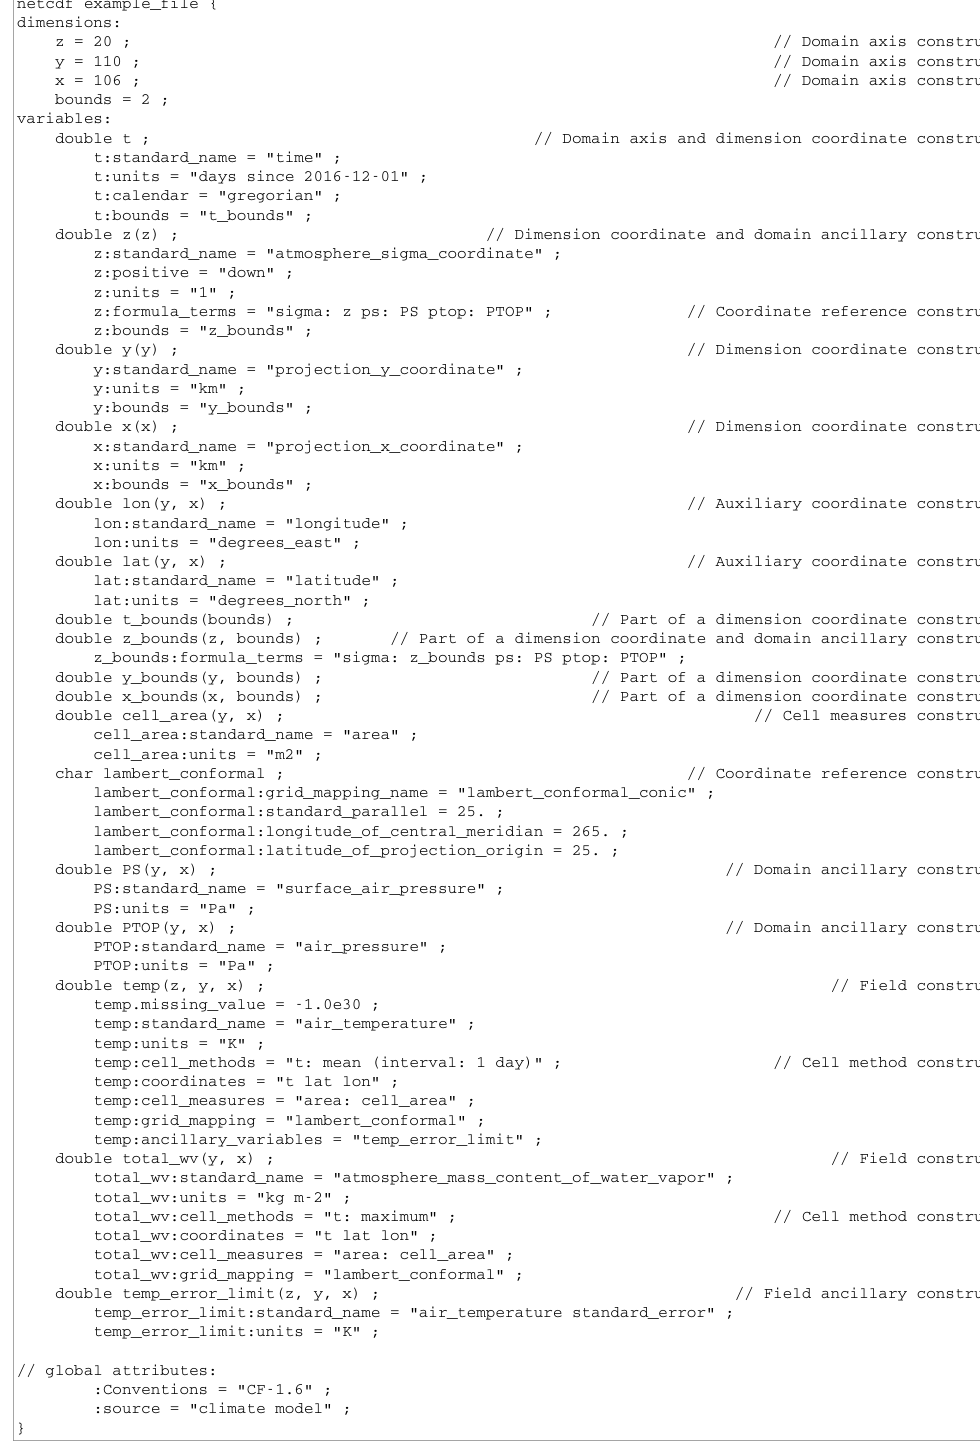
Figure 3. A CDL representation of the CF-netCDF file used for examples in Sect. 3 and to demonstrate the software implementation in Sect. 6. Data values have been omitted for brevity. Each line has a comment on the right-hand side (beginning with // ) that gives the line number and notes the data model constructs (Sect. 4) which correspond to netCDF dimensions, variables, and